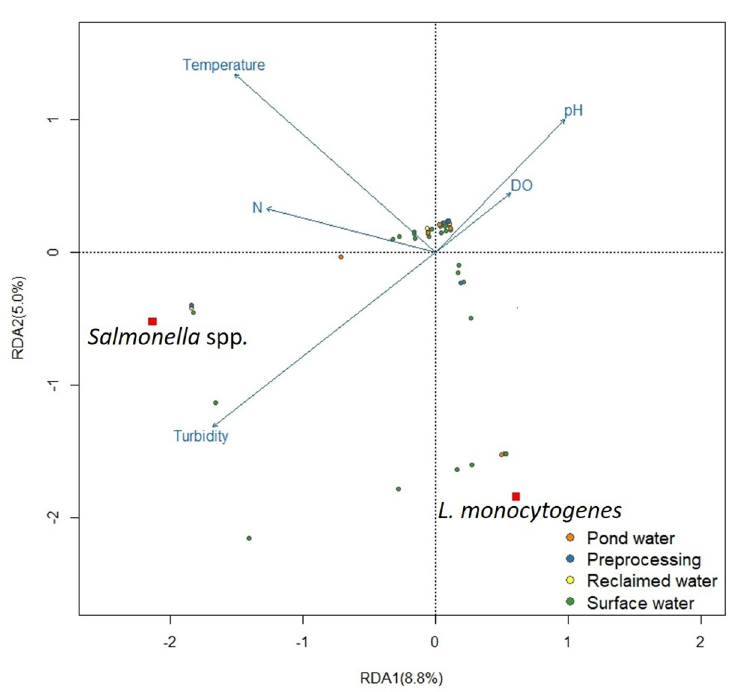
Fig 1. The total constrained variance (13.8%) is plotted on the x-axis (RDA 1 –eigenvalue 8.8%) and y-axis (RDA2 –eigenvalue 5.0%). The direction of the environmental characteristic (blue arrows) points to the direction of increase of that characteristic. Shorter distances between dots ( Salmonella spp., L . monocytogenes , water types) and water quality (blue arrows) indicate higher levels of that characteristic relative to other categorical (water types) or response (pathogen)